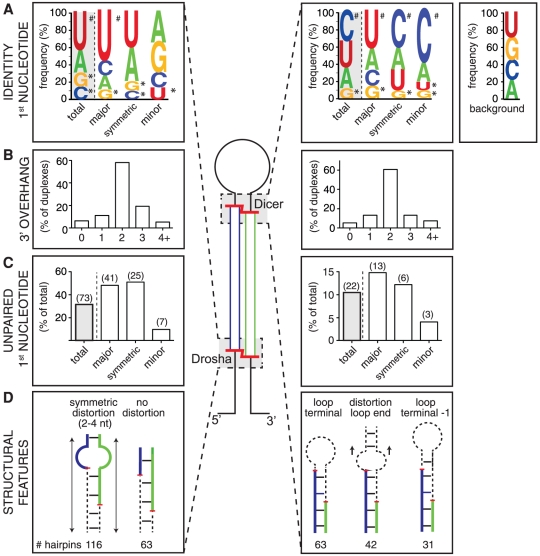
Sequence and structural features around cardiomyocyte miRNA termini.(A) Sequence logos displaying nucleoside frequency at the 5′ start position of miRNAs residing on the 5′ or 3′ hairpin arm. Results are shown averaged over all miRNAs (total), or after grouping miRNAs into asymmetrically expressed major and minor species (≥80% or ≤20% of tags from the hairpin, respectively) as well as symmetrically expressed miRNAs (less than 80%, but more than 20% of tags on any one arm of the hairpin). Significant over- (#) and under-representation (*) compared to background is also shown (p<0.01, t-test with Welch adjustment). Background was defined as the average of positions adjacent to all cleavage sites. Only generic miRNAs with expression level ≥150 tags were included in this analysis. See Figure S6 for expanded analysis. (B) Proportion of miRNAs with different 3′ overhang lengths in reconstructed duplex processing intermediates. (C) Proportion of miRNAs with an unpaired first nucleoside after grouping miRNAs as in (A). Number of miRNAs in each group is shown in brackets above. (D) Shown are schematics of the most common structural distortions on miRNA precursors surrounding miRNA termini (see Figure S7 for details). Analyses in (B–D) were performed on canonically processed miRNA hairpins with expression level ≥150 tags from at least one arm. Structural features were determined by visual inspection of the most common isomiR on each arm overlaid onto the predicted miRNA hairpin folding as deposited in miRBase.